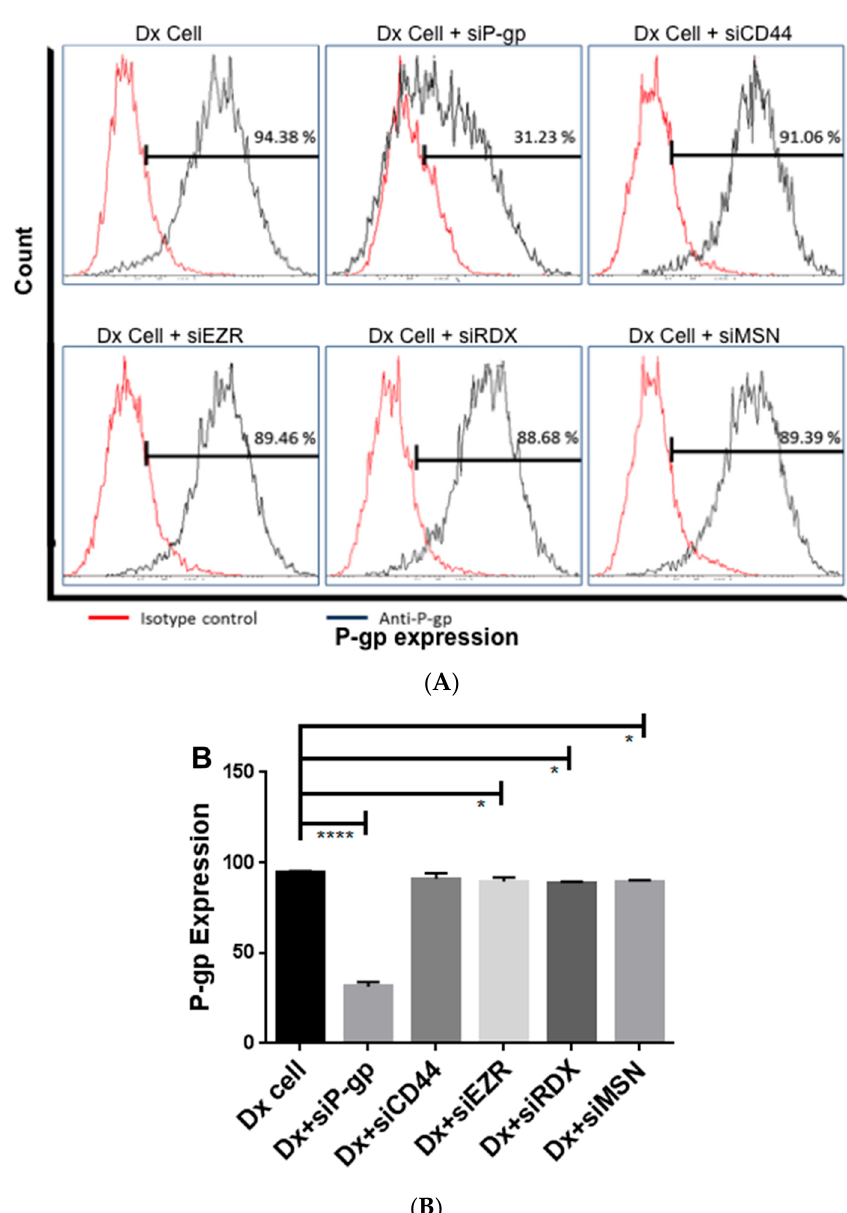
Figure 4. ( A ) Histogram and ( B ) Graph, representing the gene silencing of ERM and CD44—effect on P-gp expression in MCF-7/Dx cells: Dx-cells were silenced with siRNA targeting CD44 (siCD44), Ezrin (siEZR), Radixin (siRDX), Moesin (siMSN) and P-gp (siP-gp) over three days and P-gp expression was evaluated using FCM. Data represents mean ± SD (n = 3).